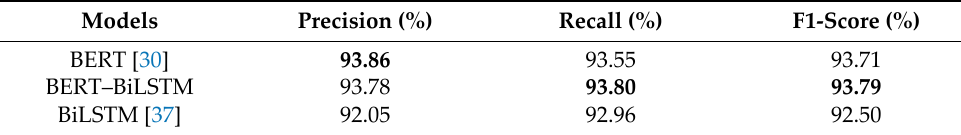
Table 5. Ablation experiment.